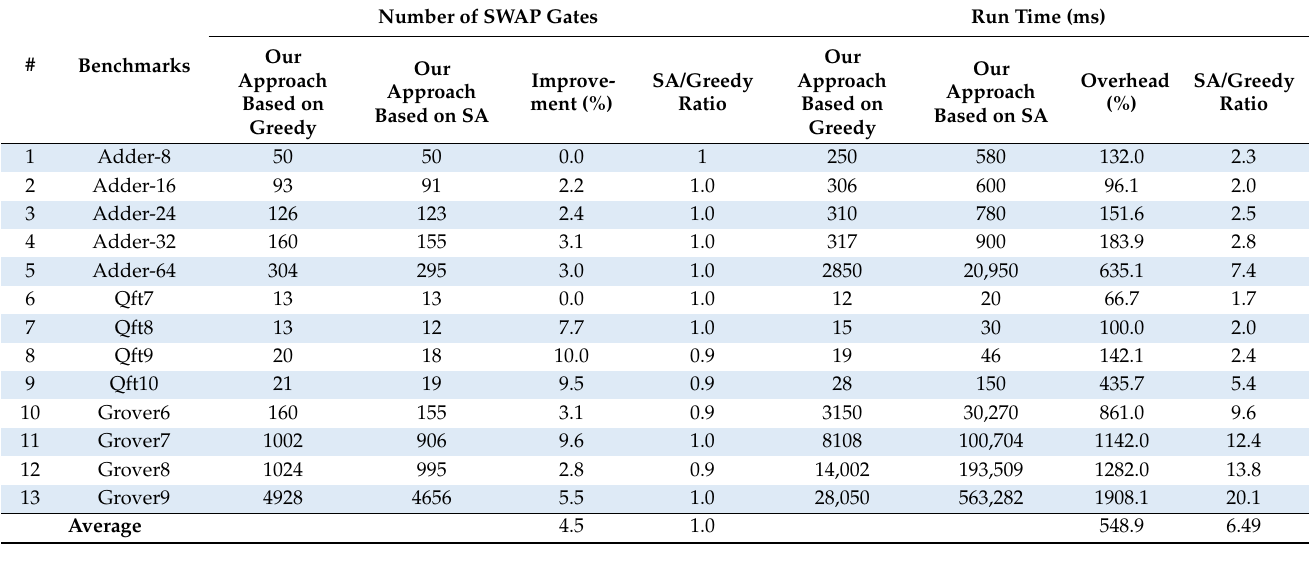
Table 2. The number of SWAP gates of the benchmark circuits achieved by using simulated annealing heuristics compared with our greedy approach in accepting or rejecting a substitution.